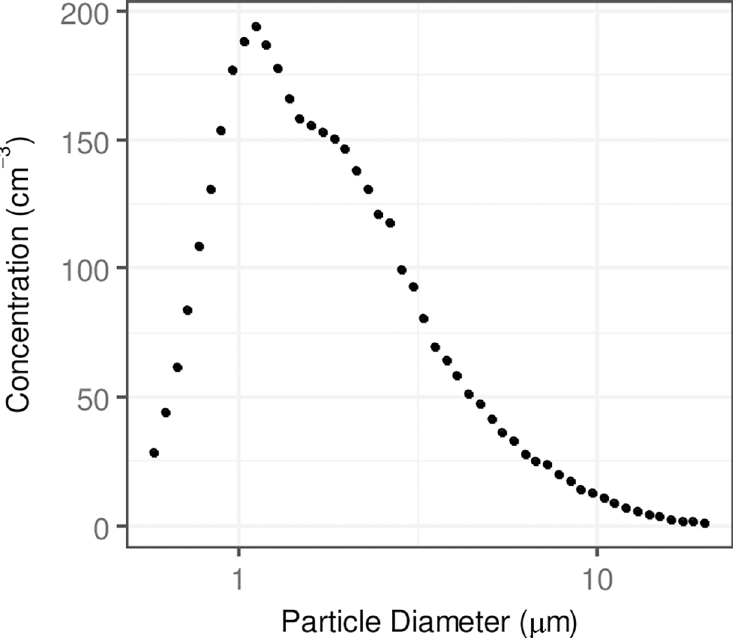
Fig 2. Total particle number size distribution of concrete dust particles as measured by the APS. The respective number size distributions were aggregated to the total size distribution.